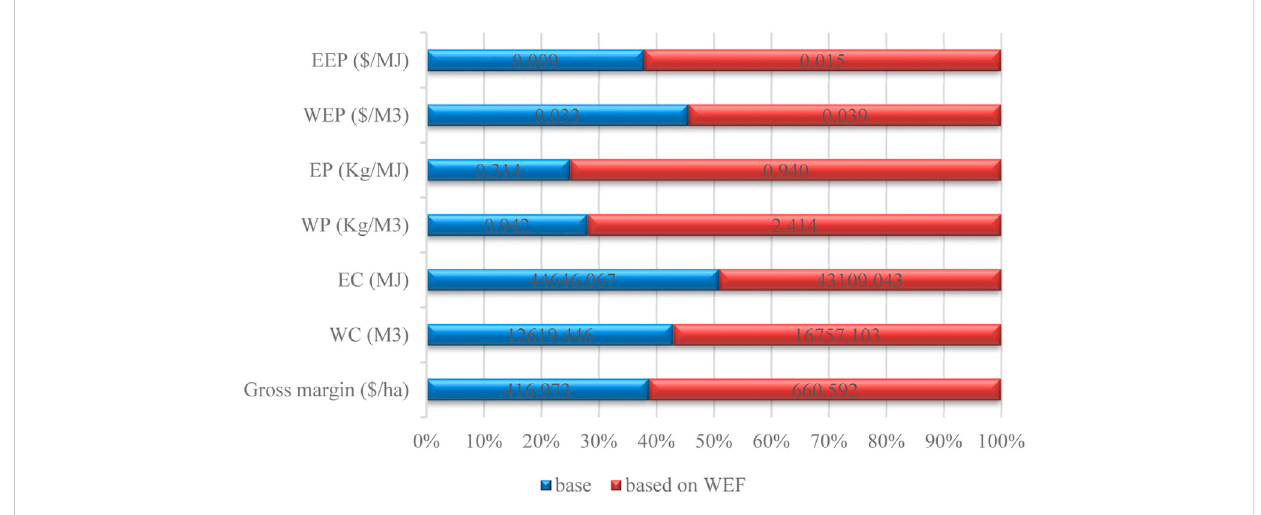
FIGURE 6 Comparison of current and proposed WEFN-based